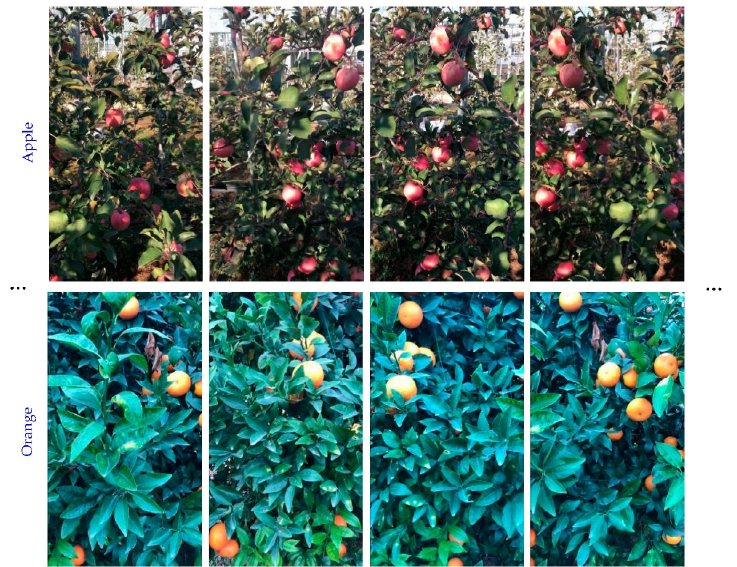
Agronomy 2022 , 12 , x FOR PEER REVIEW Figure 1. Examples of the fruit image sequences. Figure 1. Examples of the fruit image sequences.